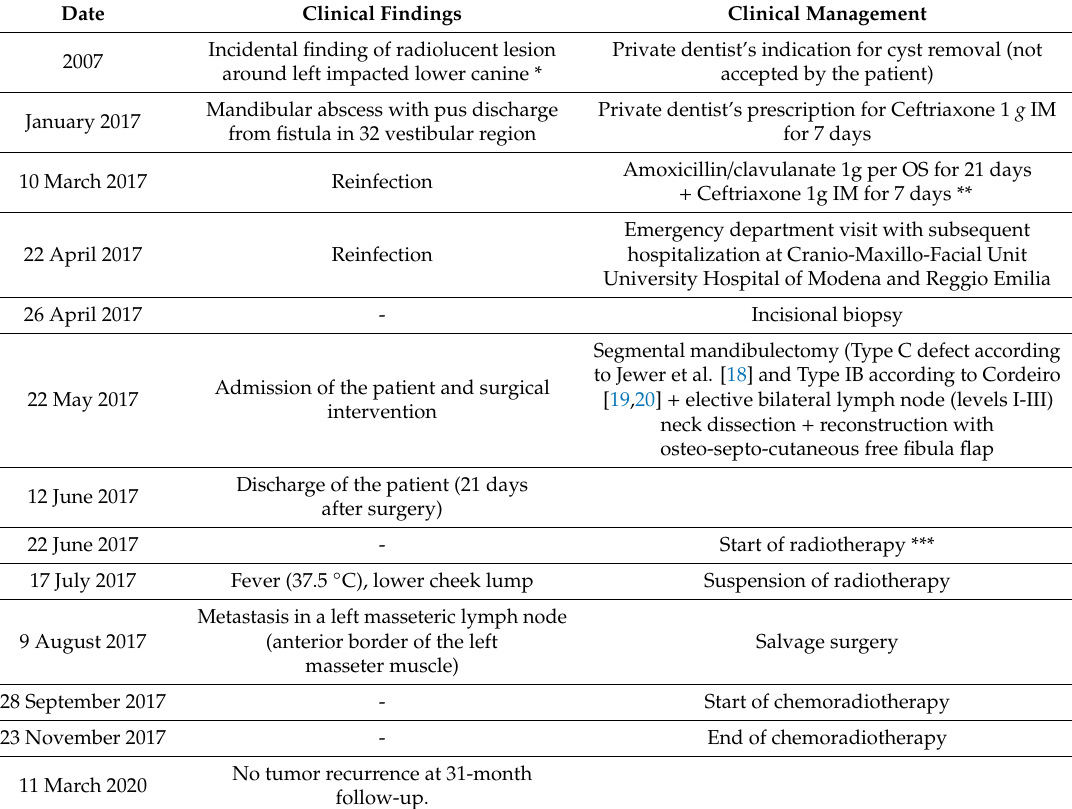
Table 2. Patient treatment